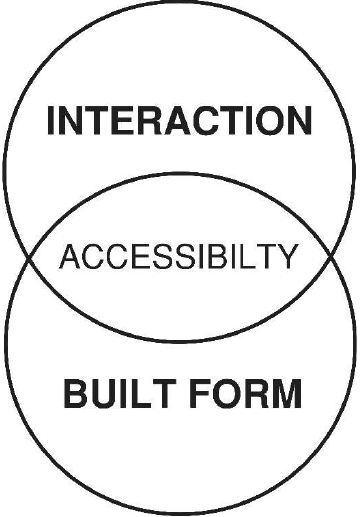
Figure 1. Relationship between built form and social interaction.